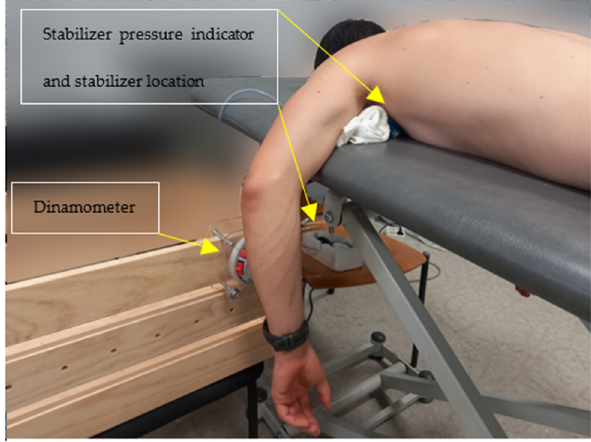
Figure 1. Position of the patient.